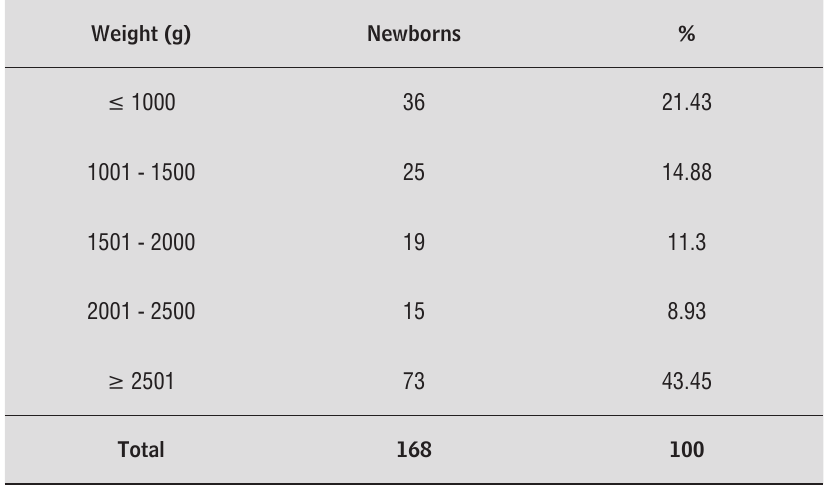
Table 1 - Relationship between the percentage of NBs and birth weight